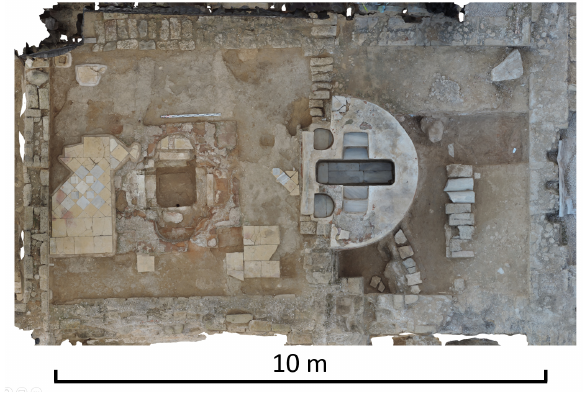
Figure 8. ortho-photo of the baptistery made from images taken by the site